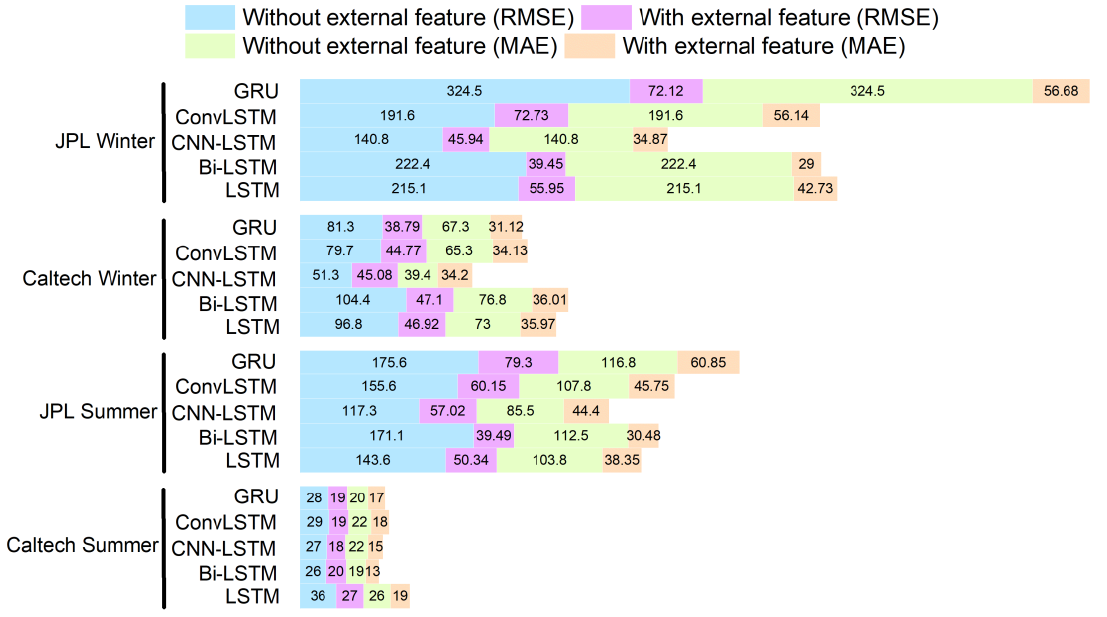
Figure 9. Forecasting performance for summer and winter days.